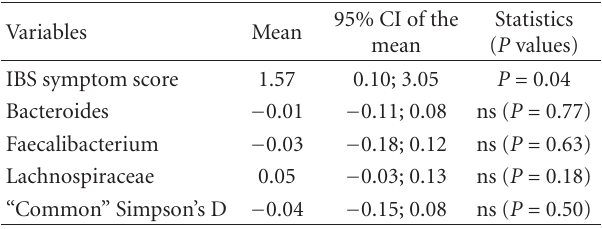
Table 2: “Treatment e ff ect” (increase during active treatment minus increase during placebo treatment) on symptoms, propor- tions of the fecal microbiota, and on fecal diversity.